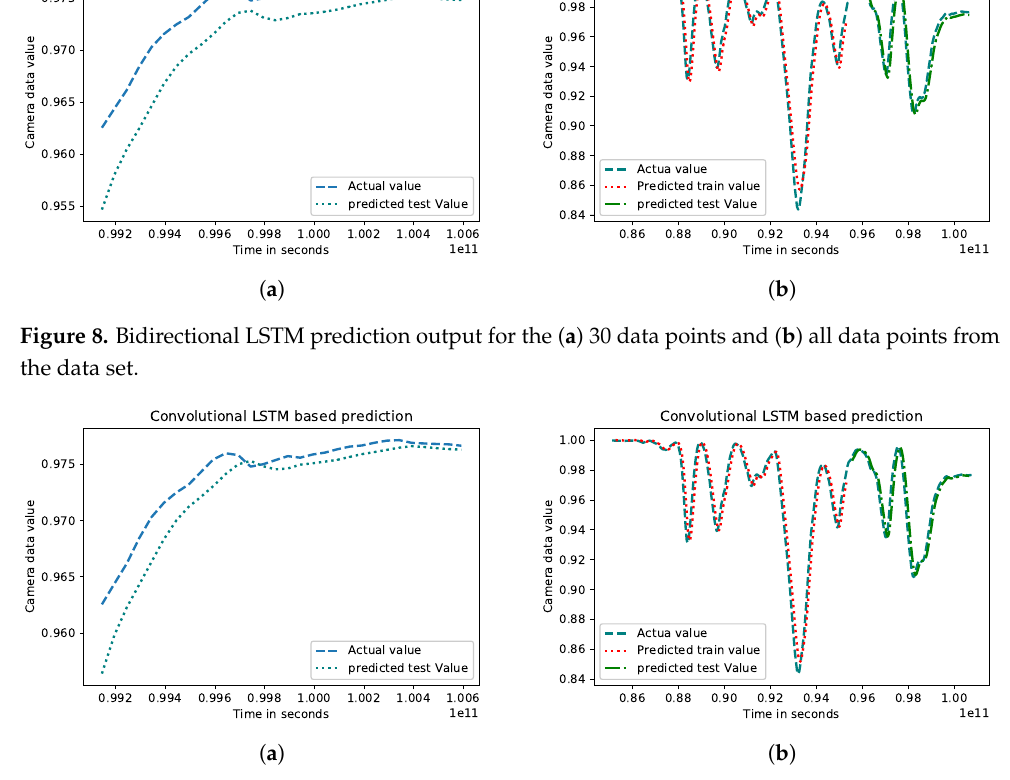
Figure 9. Convolutional LSTM prediction output for the ( a ) 30 data points and ( b ) all data points from the data set.